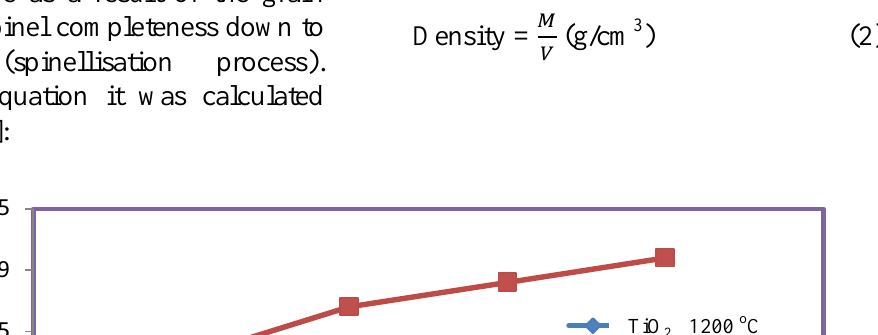
) at firing (1200 and 2